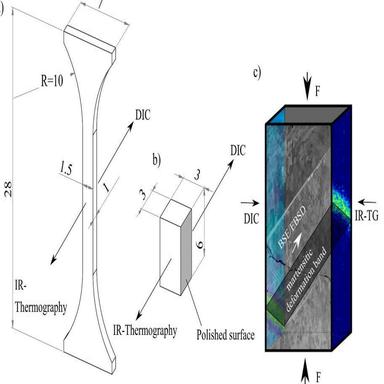
Schematic illustration of the experimental setup and specimen geometries. (a) Flat tensile specimen with a cross-section of 1 × 1.5 mm2 . (b) Compressive specimen with cross section of 3 × 3 mm2 . The arrows indicate viewing directions for DIC, EBSD and IR-TG measurements. (c) Compressive specimen with superimposed backscattered electron (BSE) contrast, IR-TG and DIC images.